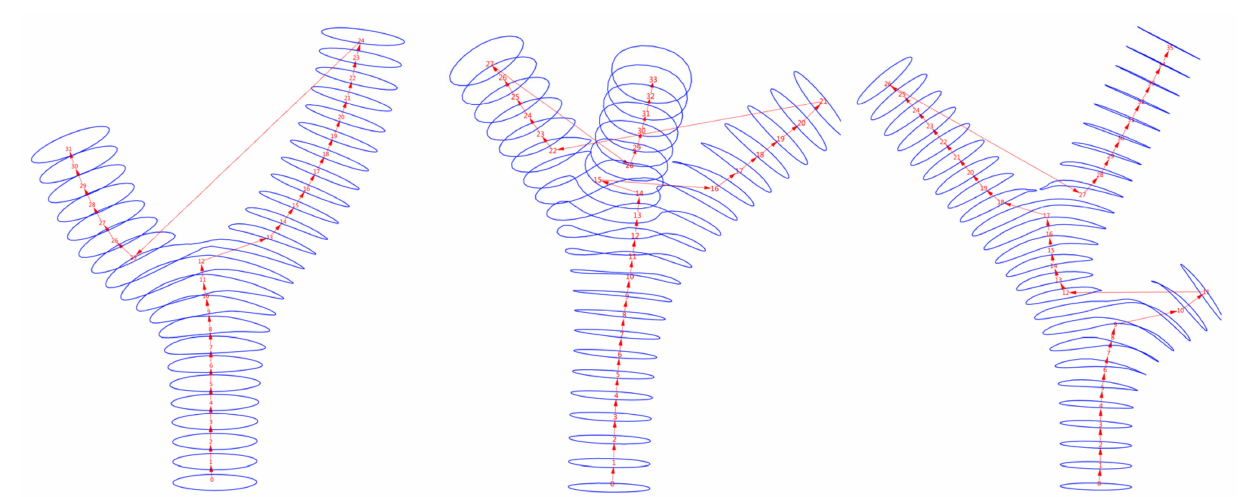
Figure 6. Depth-first